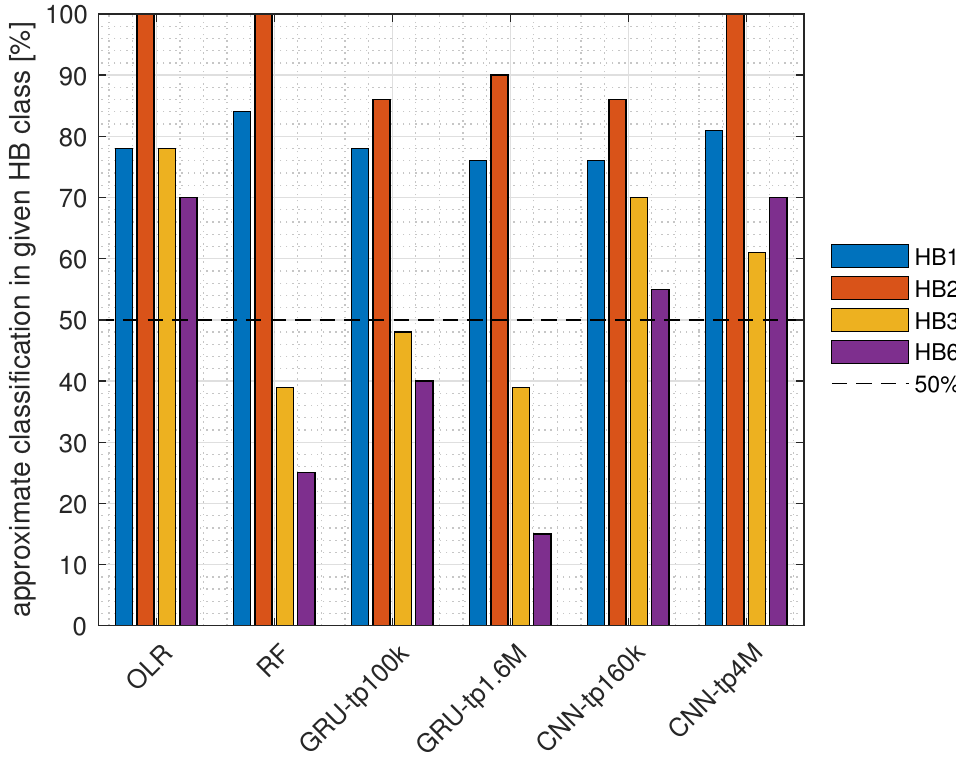
Figure 6. Accuracy of approximate classification in different HB